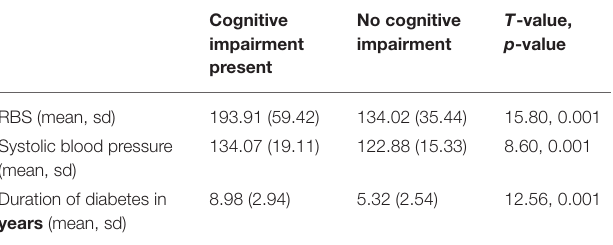
TABLE 3 | Comparison of duration of diabetes, mean RBS and systolic blood pressure across varying levels of cognition. Cognitive impairment